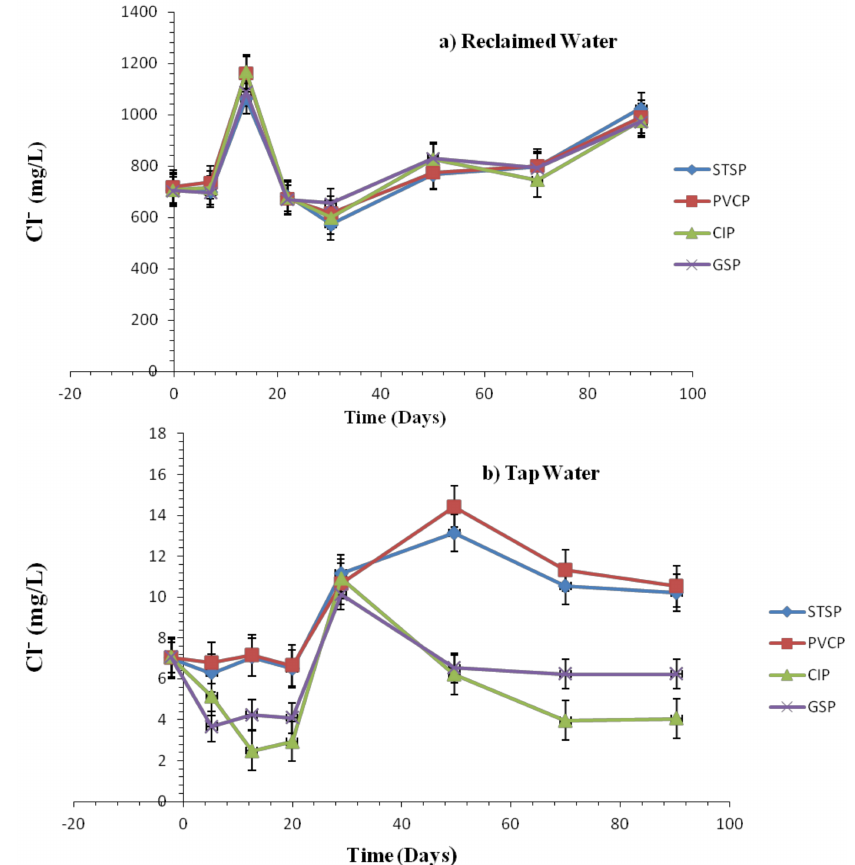
Figure 7. Variations of chloride concentration in RW and TW in stainless steel, polyvinyl chloride, cast iron, and galvanized steel pipes over time with standard error